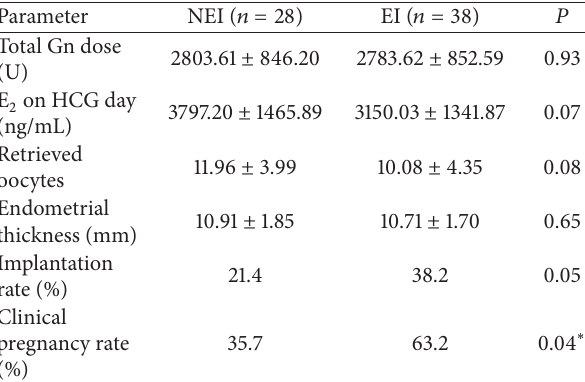
Table 2: Treatment characteristics of the NEI and EI